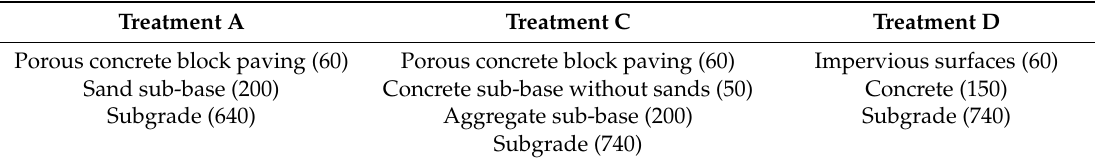
Table 1. Cross-sections of the selected permeable pavements and the control (Treatments A, C and D) used for modelling. The numbers in brackets indicate the thickness in mm. Information extracted from [11].